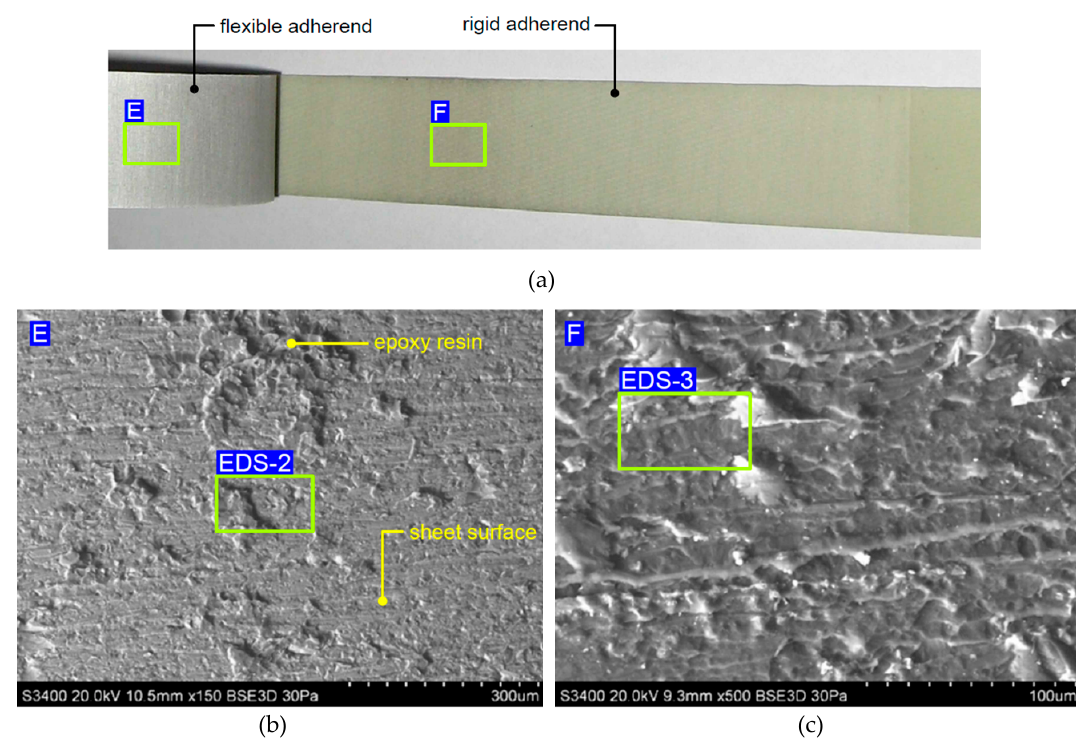
Figure 17. ( a ) View of the specimen without adhesive film, and SEM micrographs of fractured surfaces